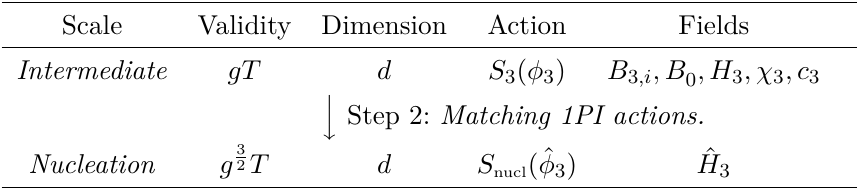
Second step of the dimensionally reduced approach, matching the intermediate scale effective action S 3 ( φ 3 ) onto the nucleation scale effective action S fields between the two by using a circumflex for the nucleation scale EFT